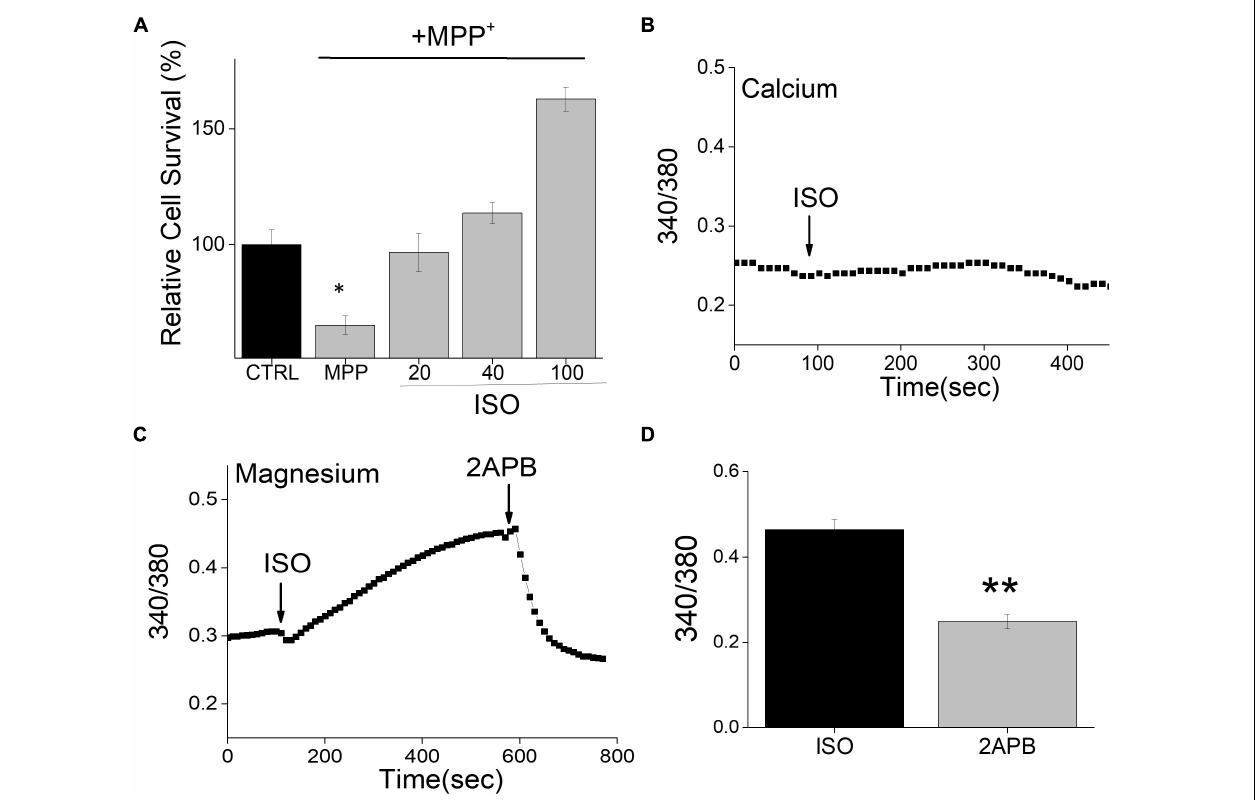
FIGURE 1 | Isoproterenol treatment induces survival of neuroblastoma cells: (A) Cell survival under conditions as labeled was performed using MTT assays on control and MPP + (500 µ M for 24 h) treated SH-SY5Y cells. The conditions used were control (mock treatment), ISO 20, 40, and 100 µ M, which was added 15 min prior to the addition of MPP + . Individual columns show the means ± SD of 5 separate experiments performed in triplicates (* p < 0.05, ** p < 0.01; One-way ANOVA, Tukey post hoc test). (B) Ca 2 + imaging in Fura 2 loaded cells was performed by the application of ISO (100 µ M) in normal SES (1 mM Ca 2 + , 1 mM Mg 2 + ) solution in SH-SY5Y cells. (C) Mg 2 + imaging was performed using mag-Fura in normal SES (1 mM Ca 2 + , 1 mM Mg 2 + ) solution using differentiated SH-SY5Y cells. Application of ISO (100 µ M) in the external solution induces Mg 2 + influx and addition of 2APB (100 µ M) inhibits Mg 2 + influx in these cells. (D) Quantification (mean ± SE) of intracellular Mg 2 + concentrations are also included as bar